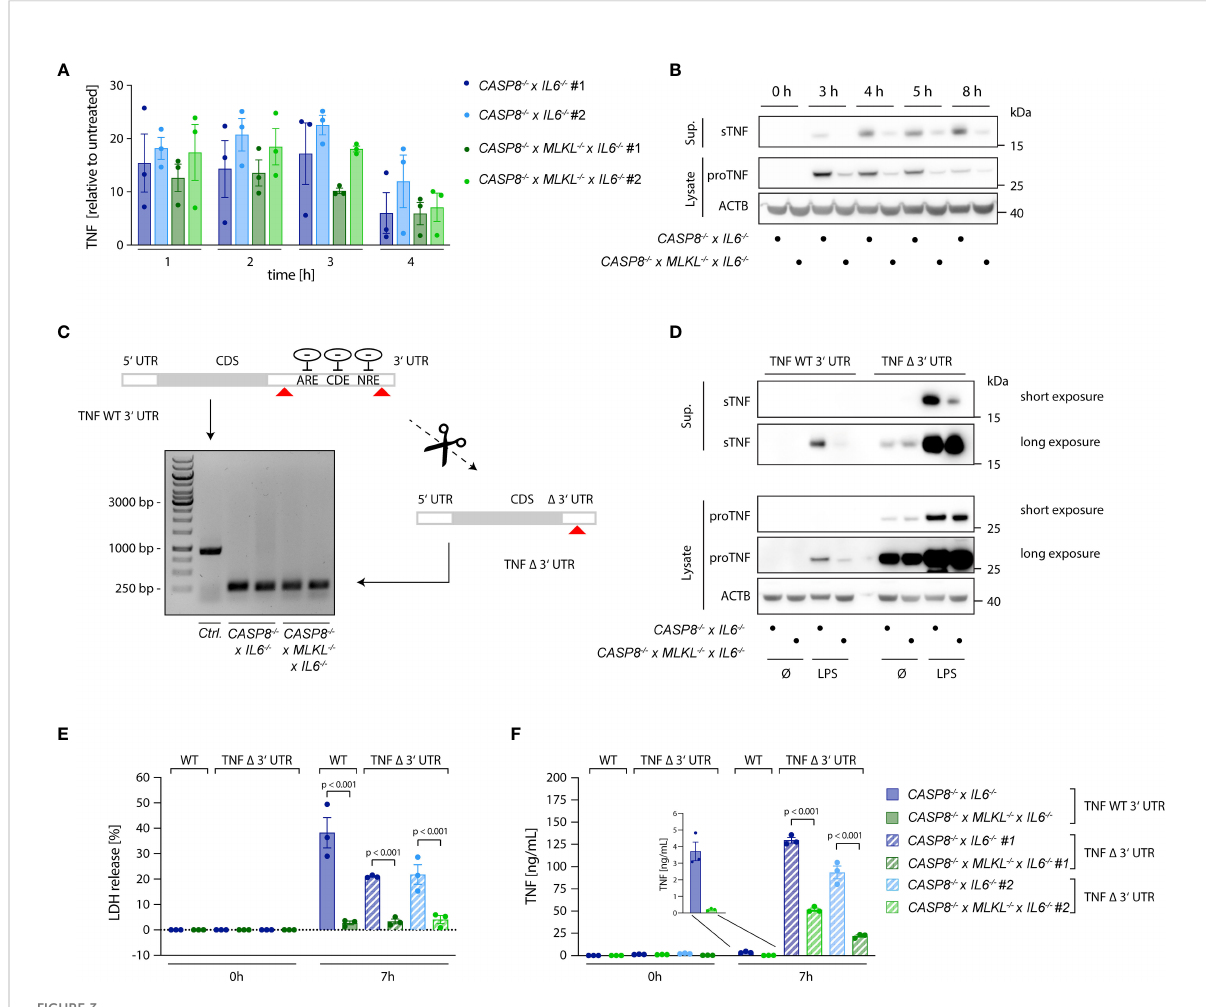
FIGURE 3 Necroptosis boosts TNF translation. (A) qPCR of TNF induced upon stimulation with 2 ng/ml LPS in the indicated cells. Results are shown as fold change relative to unstimulated cells. (B) Immunoblotting of pro-TNF (cell lysates) and sTNF (supernatants) of CASP8 -/- x IL6 -/- and CASP8 -/- x MLKL -/- x IL6 -/- cells upon stimulation with 2 ng/ml LPS for the indicated time points. ACTB was detected as loading control. (C) CASP8 -/- and CASP8 -/- x MLKL -/- BLaER1 cells de fi cient for the 3 ’ UTR of the TNF gene (TNF D 3 ’ UTR) were generated by employing two gRNAs targeting the 3 ’ UTR at its very beginning and very end, respectively (red arrows). The removal of the 3 ’ UTR was assessed by PCR (Control = long PCR product, TNF D 3 ’ UTR = short PCR product). Two clones of TNF D 3 ’ UTR are shown per parental genotype. (D) BLaER1 cells of the indicated genotypes were stimulated with LPS (2 ng/ml) for 7 h pro-TNF expression and matured TNF were assessed by immunoblotting. (E, F) BLaER1 cells of the indicated genotypes were stimulated with LPS (2 ng/ml) for 7 h. Cell death was evaluated by LDH assay (E) . Secreted TNF was measured by ELISA (F) . Data are depicted as mean ± SEM of three independent experiments or as one representative immunoblot of three independent experiments (B, D) . Statistics indicate signi fi cance by two-way ANOVA with a Tukey correction for multiple testing (E, F) , whereas p values are as indicated. Statistics for data in (A) were calculated using a repeated measures two-way ANOVA, whereas none of the comparisons reached statistical signi fi cance (not